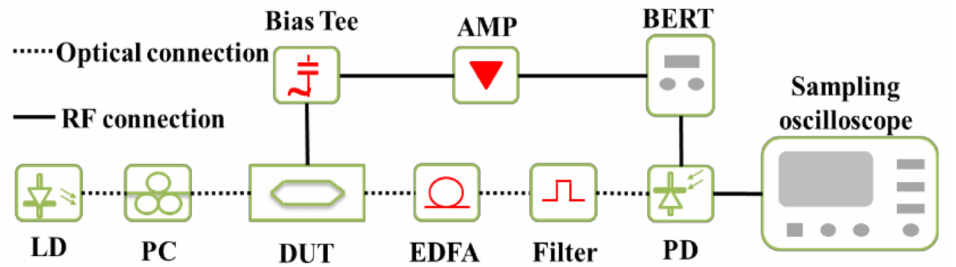
Figure 2. Experimental setup of measurement system used to characterize a Mach–Zehnder modula- tor